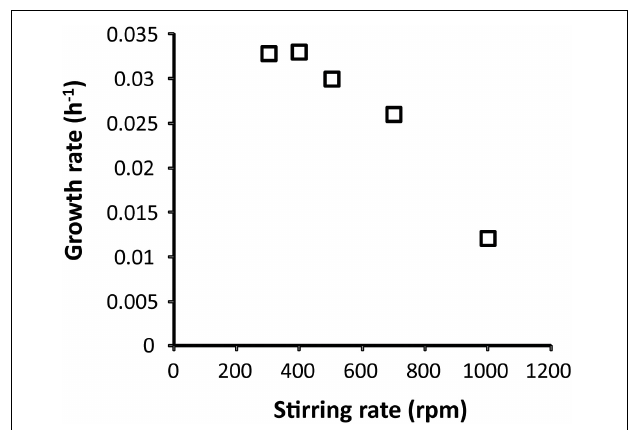
FIGURE 1 | Effect of increased stirring on the growth rate of Methylacidimicrobium tartarophylax 4AC with methane as a substrate. Each data point represents the average of two independent experiments at the same stirring